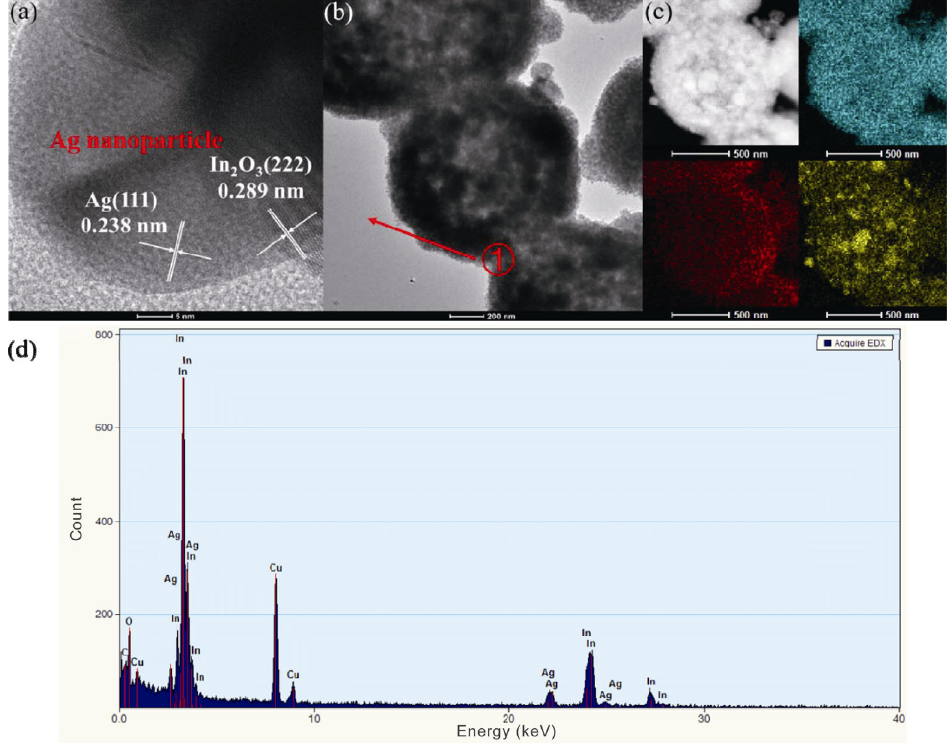
Fig. 6 (a) Lattice image, (b) HRTEM images, (c) the selected SEM image and the corresponding elemental mapping image, and (d) EDS mapping of